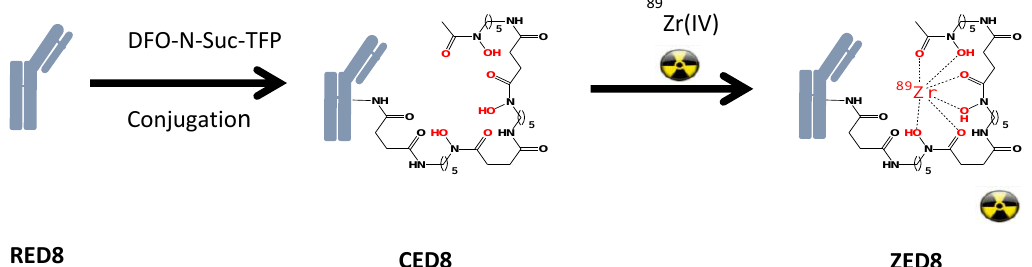
Figure 4. Anti-CD8: the immuno-PET imaging agent. DFO-N-Suc-TFP = N-succinyl-desferrioxamine-tetrafluorphenol ester.